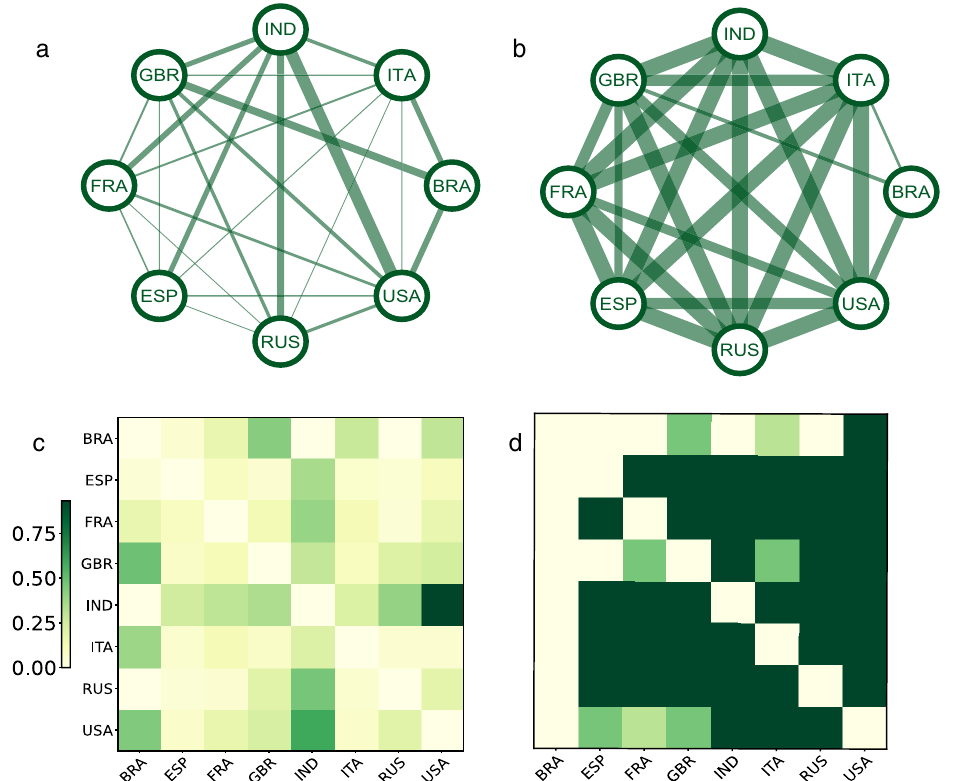
Figure 5. Airline travel network visualizations and corresponding heat maps for eight countries: the United States of America (USA), Brazil (BRA), Russia (RUS), the United Kingdom (GBR), Spain (ESP), Italy (ITA), France (FRA), and India (IND). (a) Actual airline travel volume in the first two weeks of June 2020; (b) hypothetical travel volume in the same period following our proposed policy; heat maps of (c) empirical and (d) hypothetical travel volumes normalized by travel volumes from the first two weeks of June